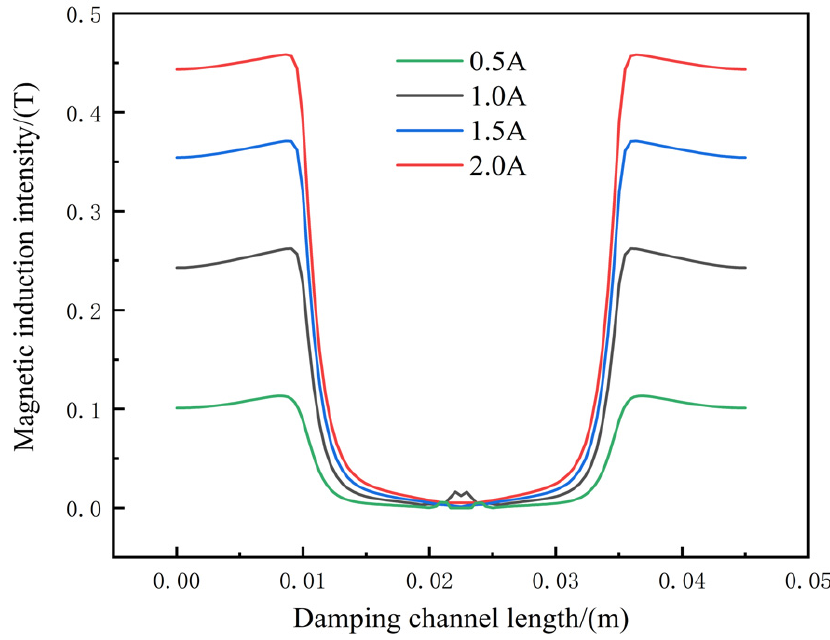
Figure 6. Magnetic flux density curves of different currents’ damping channels.